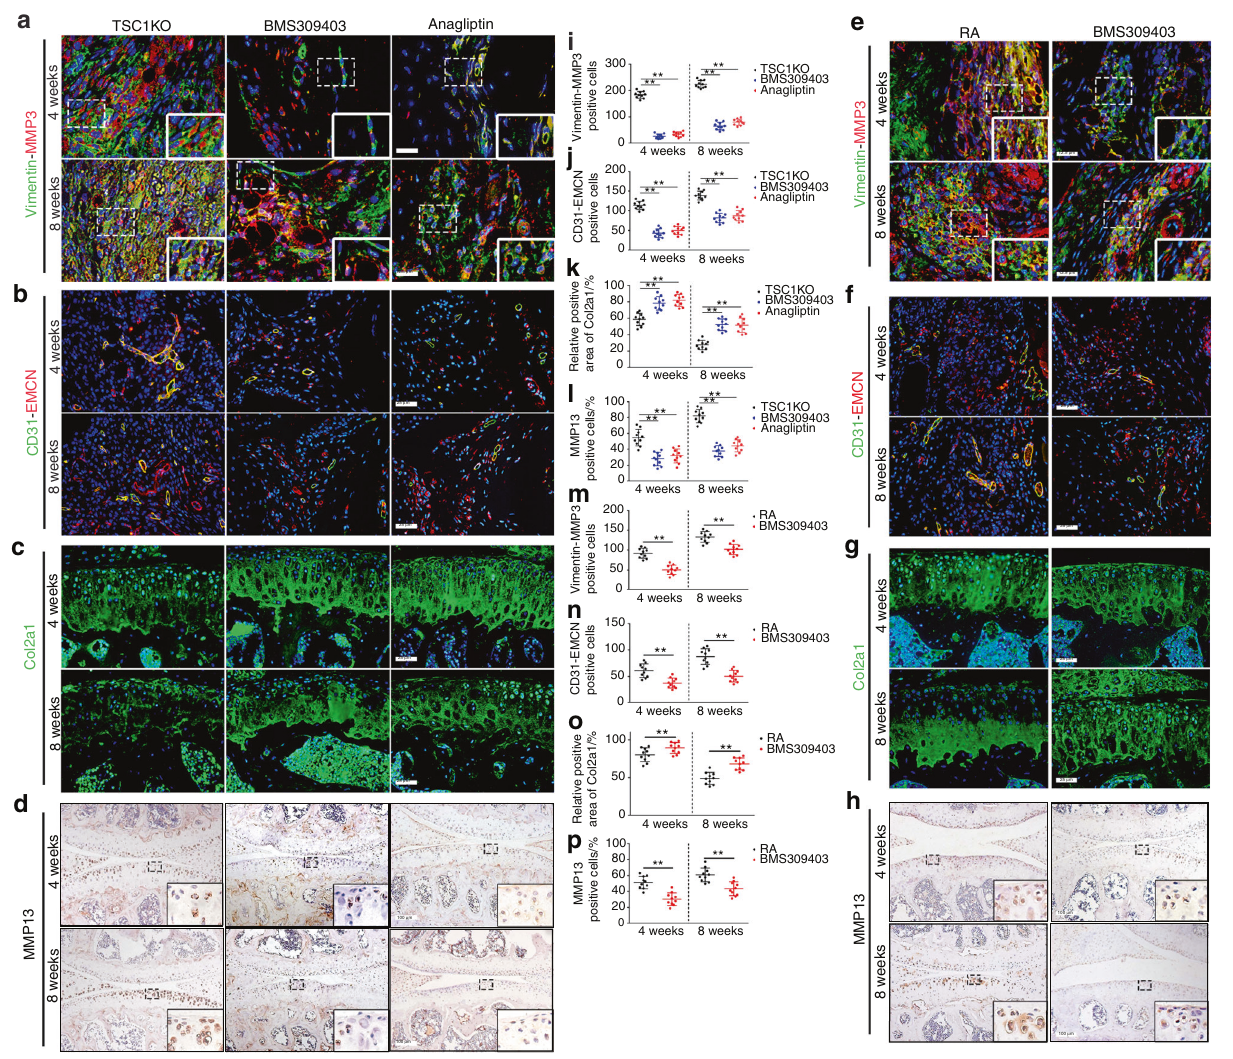
Fig. 7 Inhibiting FABP4 prevents RA development. a – d Representative images of Vimentin and MMP3 coimmunostaining ( a ), CD31 and EMCN coimmunostaining ( b ), Col2a1 immuno fl uorescence staining ( c ), and immunohistochemical staining of MMP13 ( D ) in the knee joints of TSC1KO mice treated with vehicle, BMS309403 or anagliptin for 4 and 8 weeks after AIA modeling. Scale bar: 12.5 µm, 25 µm, and 100 µm. e – h Representative images of Vimentin and MMP3 coimmunostaining ( e ), CD31 and EMCN coimmunostaining ( f ), Col2a1 immuno fl uorescence staining ( g ), and immunohistochemical staining of MMP13 ( h ) in the knee joints of RA mice treated with vehicle or BMS309403 for 4 and 8 weeks. Scale bar: 12.5 µm, 25 µm, and 100 µm. i – l Quanti fi cation of Vimentin-MMP3 ( i ), CD31-EMCN ( j ), Col2a1 ( k ), and MMP13 ( l ) in TSC1KO mice treated with vehicle, BMS309403, or anagliptin for 4 and 8 weeks after AIA surgery ( n = 10 per group). m – p Quanti fi cation of Vimentin- MMP3 ( m ), CD31-EMCN ( n ), Col2a1 ( o ), and MMP13 ( p ) in RA mice treated with vehicle or BMS309403 for 4 and 8 weeks ( n = 10 per group). Student ’ s t -test or one-way ANOVA and Tukey ’ s multiple comparison test were used. ** P < 0.01. The data are shown as the mean ±